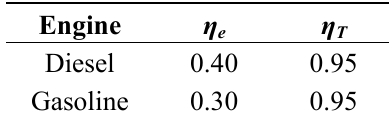
Table 3. The vehicle-specific parameters used were the type of engine, automobile mass, rated power and engine speed. Table 2. The values of common parameters used in our calculations.